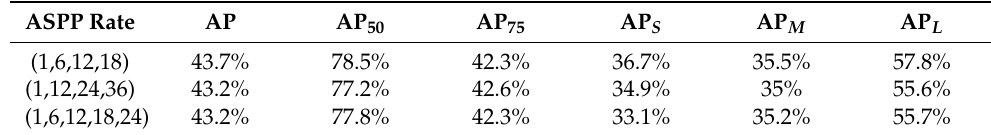
Table 2. Comparison of different rates in the ASPP module.